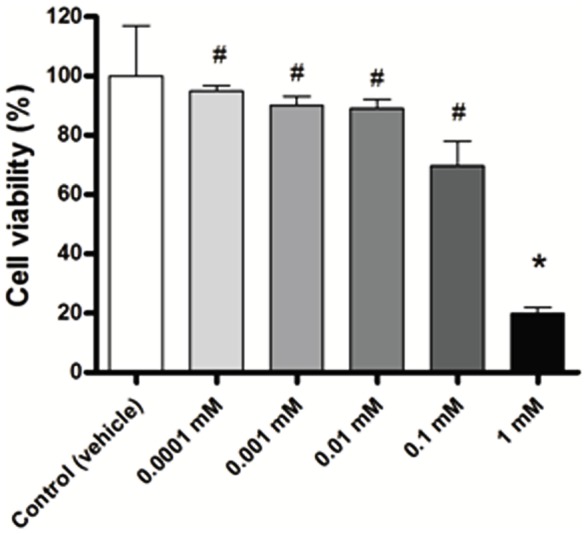
Inhibitory effect of melatonin on viability of the MDA-MB-231 cell line.The MDA-MB-231 cells were treated with five concentrations of melatonin for 24 h and cell viability was measured by MTT assay. Data are shown as mean ± S.D. *p<0.05, 1 mM of melatonin vs. Control; #p<0.05, 1 mM of melatonin vs other melatonin's concentrations.